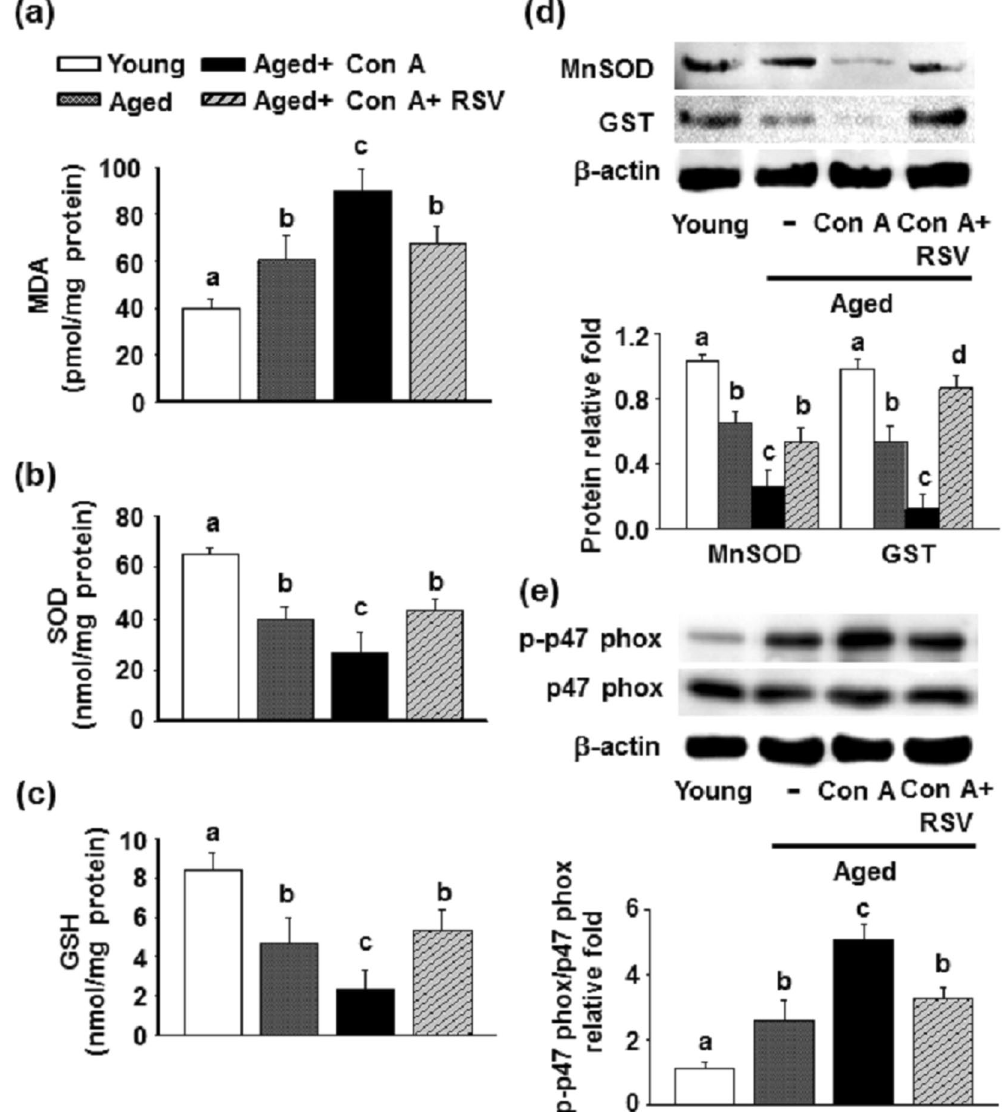
Figure 4. Effects of resveratrol on oxidative stress in the livers of aged mice challenged with Con A. ( a ) Hepatic lipid peroxidation levels represented as MDA equivalents (n = 7 in each group). ( b ) Hepatic SOD and ( c ) GSH assays (n = 7 in each group). ( d ) The protein levels of the MnSOD, GST, and ( e ) total and phosphorylated forms of p47 phox were determined by Western blotting. The results are expressed as the means ± SEMs from three independent measurements. Different letters denote statistically significant differences (p < 0.05) between